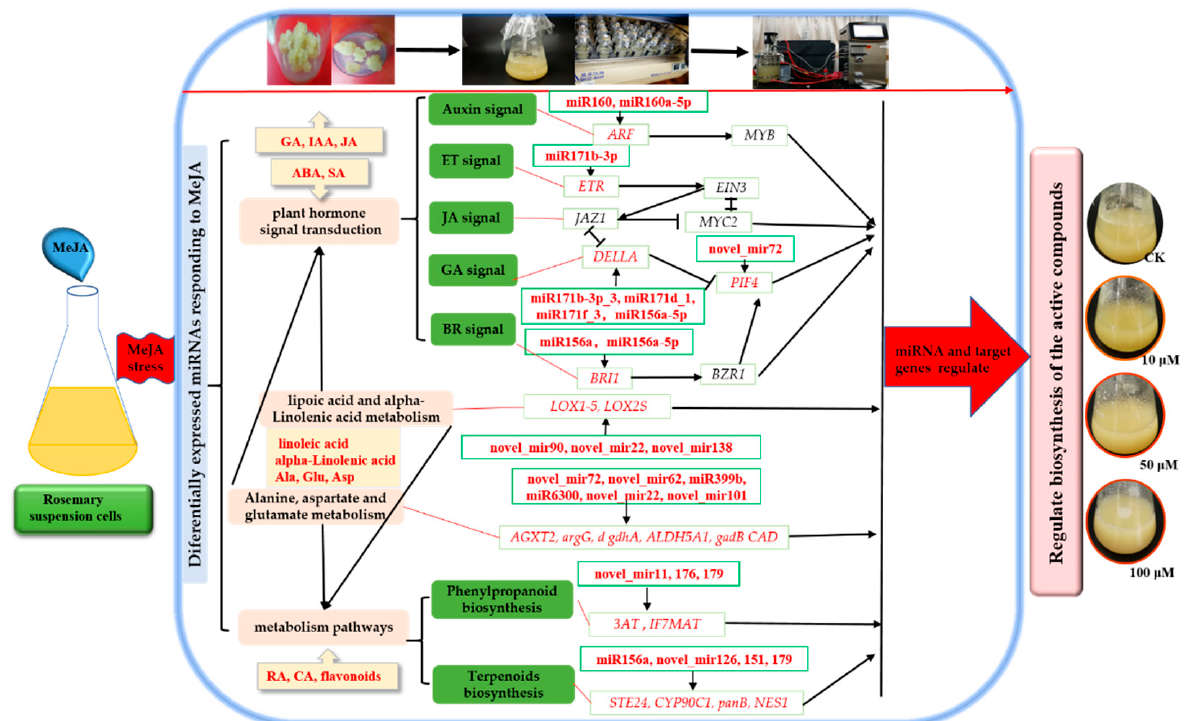
Figure 9. Model depicting the regulatory miRNA-mediated mechanisms of metabolite biosynthesis under MeJA. Differentially expressed miRNAs and their target genes of plant hormone signal trans- duction; lipoic acid metabolism; alpha-linolenic acid metabolism; alanine, aspartate and glutamate metabolism; and phenylpropanoid and terpenoids biosynthesis pathways which played an essential beneficial in rosemary suspension cells responding to MeJA. The picture shows rosemary cell culture system. The parameters, miRNAs, and target genes named in red indicate the difference of level and expression under different concentrations of MeJA.